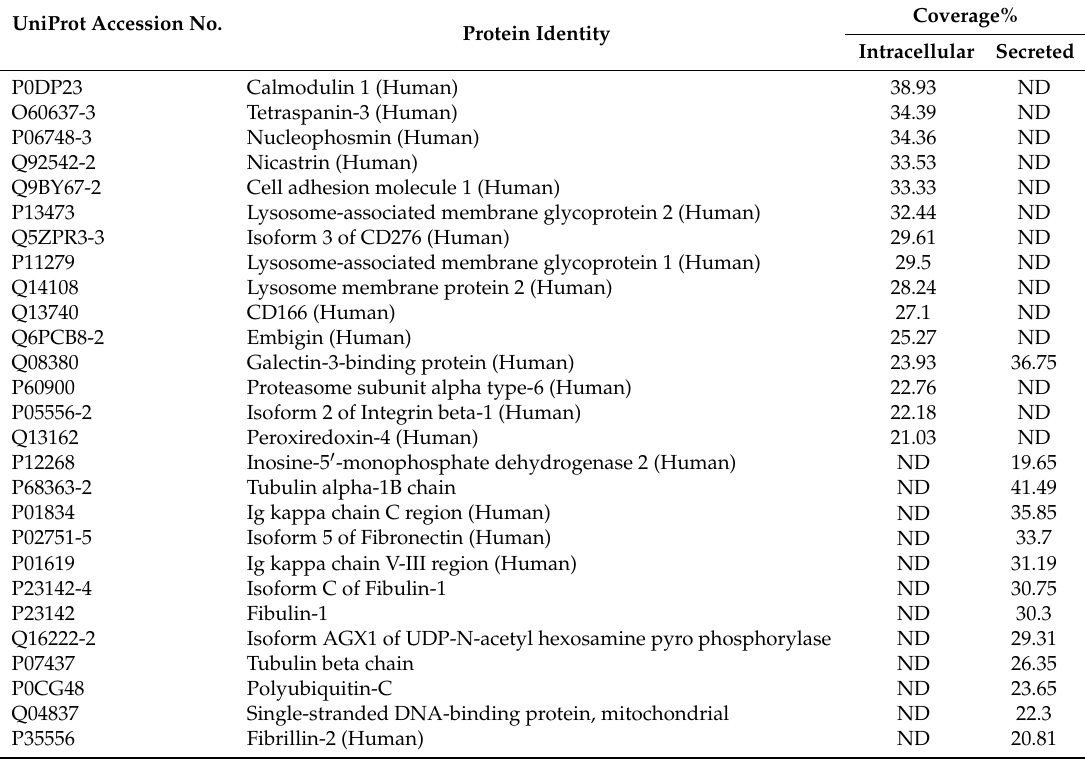
Figure 5. Host-cell protein (HCP) identification in intracellular and secreted AAV8 using Proteome Discoverer 1.4 . Table 1. HCP identification using Proteome Discoverer 1.4 .